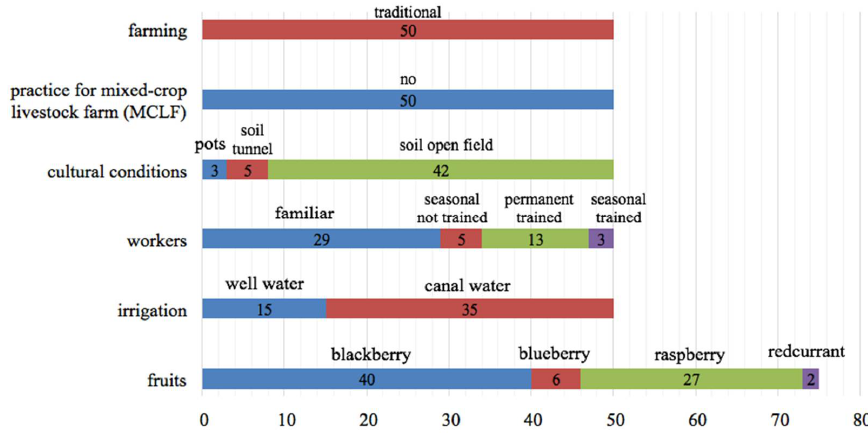
Figure 1. Results of the questionnaire.